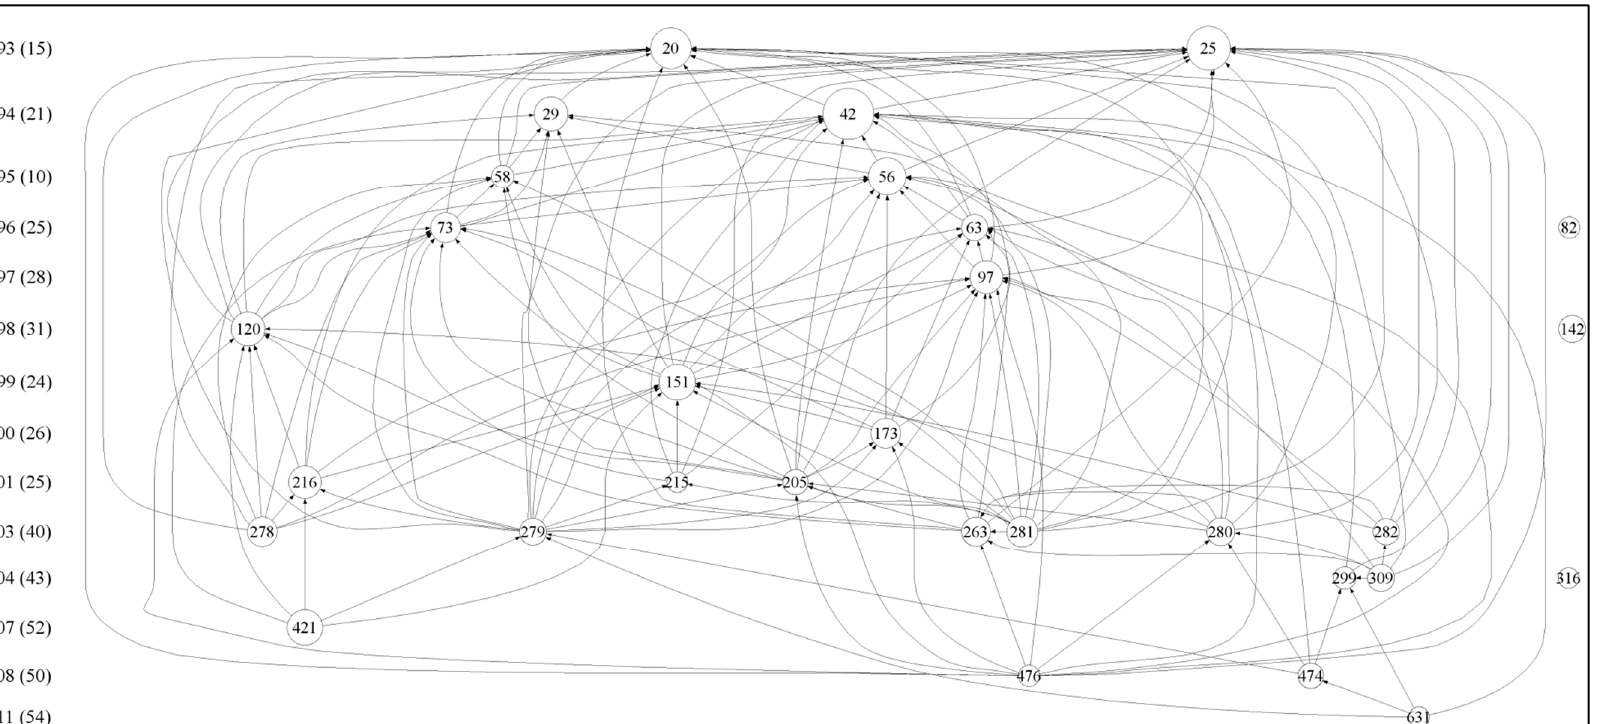
Figure 4. Citation network of top 30 publications on heat pulse method for soil physical measurements produced by Histcite based on data (1992–2019) downloaded from the Web of Science Core Collection (WoSCC). The left column is year (number of publications of that year on this topic) corresponding to the nodes/circles shared the same horizontal lines. Each circle represents a top cited publication and the inside number is the publication ID (ordered by year and author’s name) given by the Histcite. The size of a node/circle is associated with the number of times it was cited, and a larger node had more citations. The more arrows around a noodle/circle indicate that it was more often cited. The numbers inside the circles and their respective publications are: 20 [8], 25 [58], 29 [41], 42 [59], 56 [78], 58 [42], 63 [79], 73 [80], 82 [67], 97 [60], 120 [81], 142 [68], 151 [61], 173 [46], 205 [82], 215 [18], 216 [65], 263 [83], 278 [62], 279 [19], 280 [63], 281 [84], 282 [85], 299 [86], 309 [87], 316 [69], 421 [66], 474 [64], 476 [88] and 631 [89].